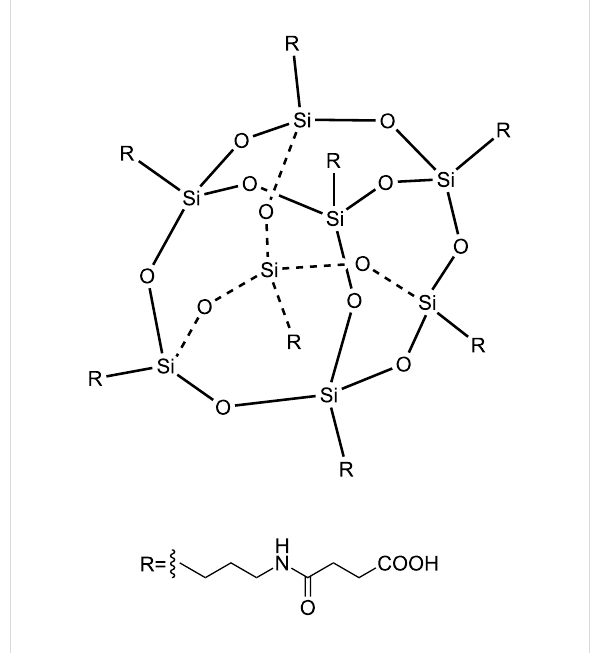
Figure 1: Chemical structure of OCPS (C 56 H 96 N 8 O 36 Si 8